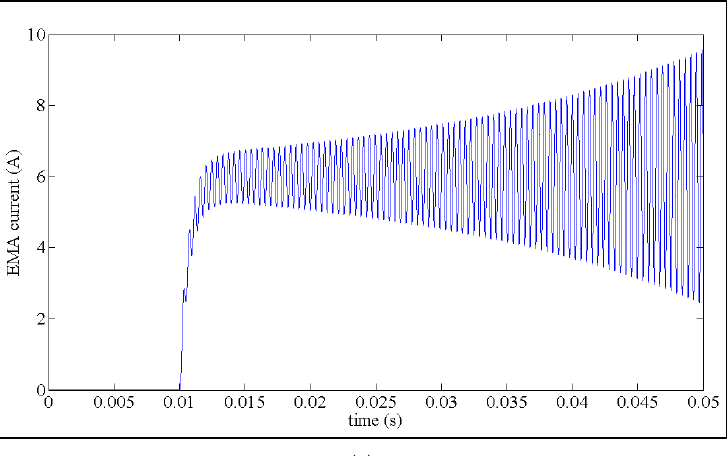
Figure 5. Stable operating range of the EMA emulator ( 𝑦 is output of the closed-loop system (in- ductor current)).